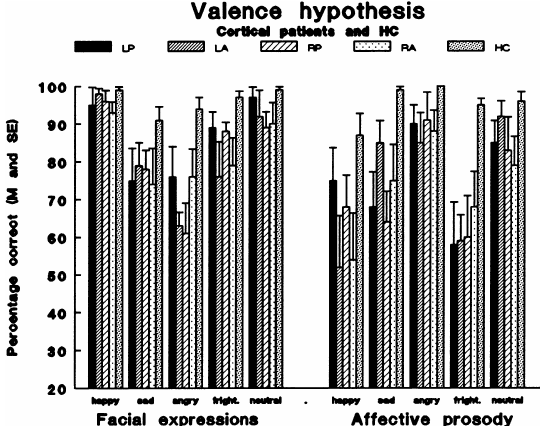
Fig. 2. Percentage correct (mean and standard error) for single emotional categories in facial expressions and affective prosody subtests of the different patient groups and healthy controls (RA = patients with right anterior damage; RP = patients with right posterior damage; LA = patients with left anterior damage; LP = patients with left posterior damage; HC = healthy controls; fright. =